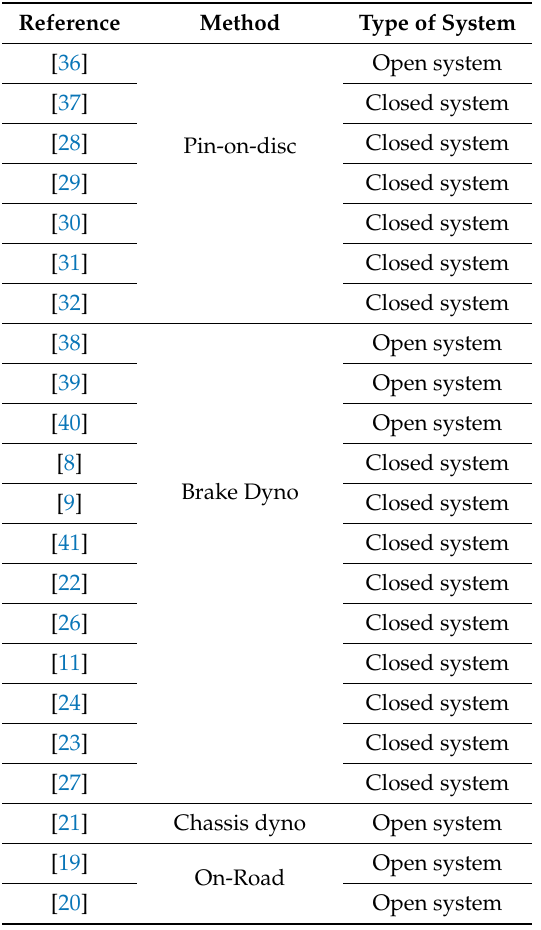
Table 1. Overview of different setups employed by different researchers for studying brake particle